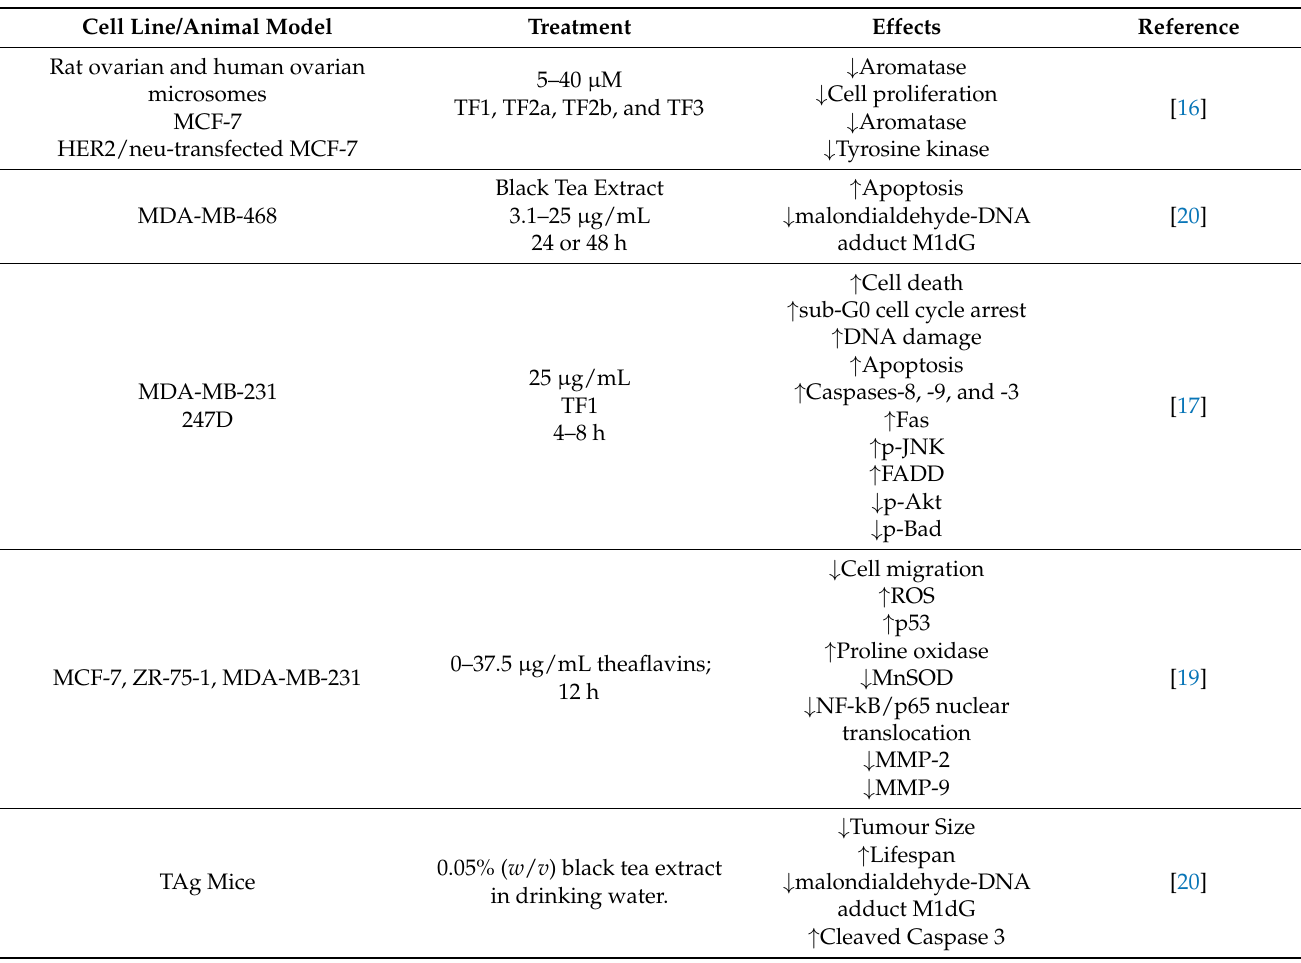
Table 1. Effects of theaflavins in breast